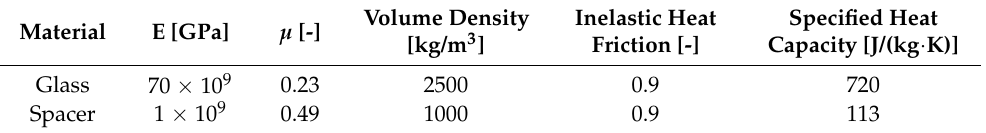
Table 2. Material properties used in FE